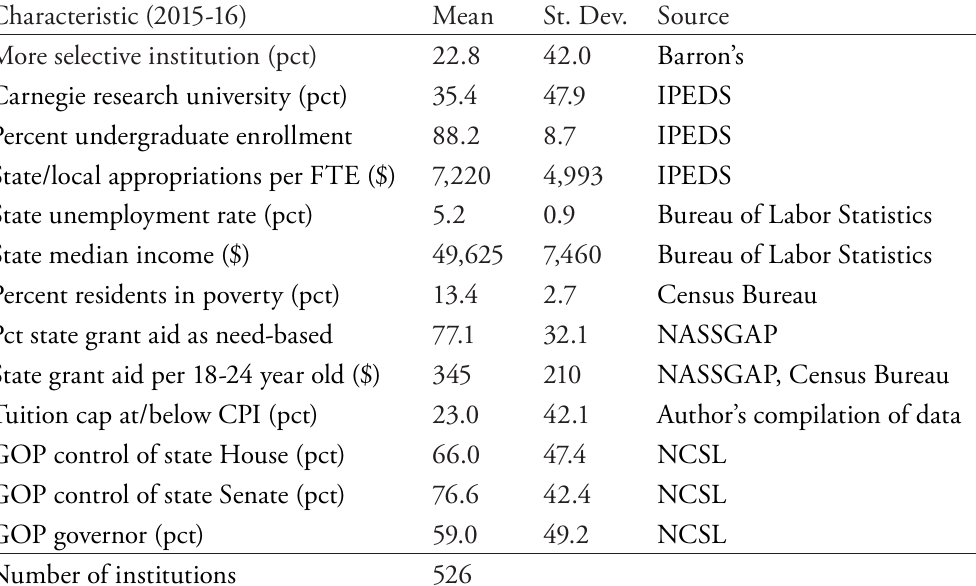
Table 2: Description of institutional-level and state-level control